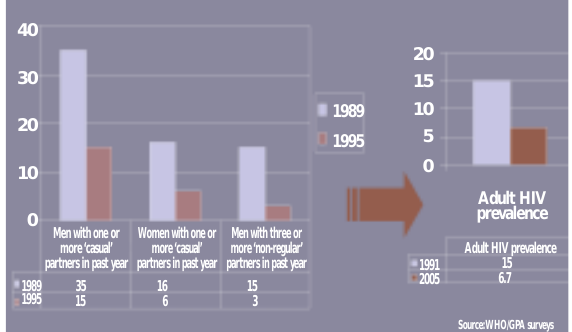
Fig. 6. Behavioural and HIV trends in